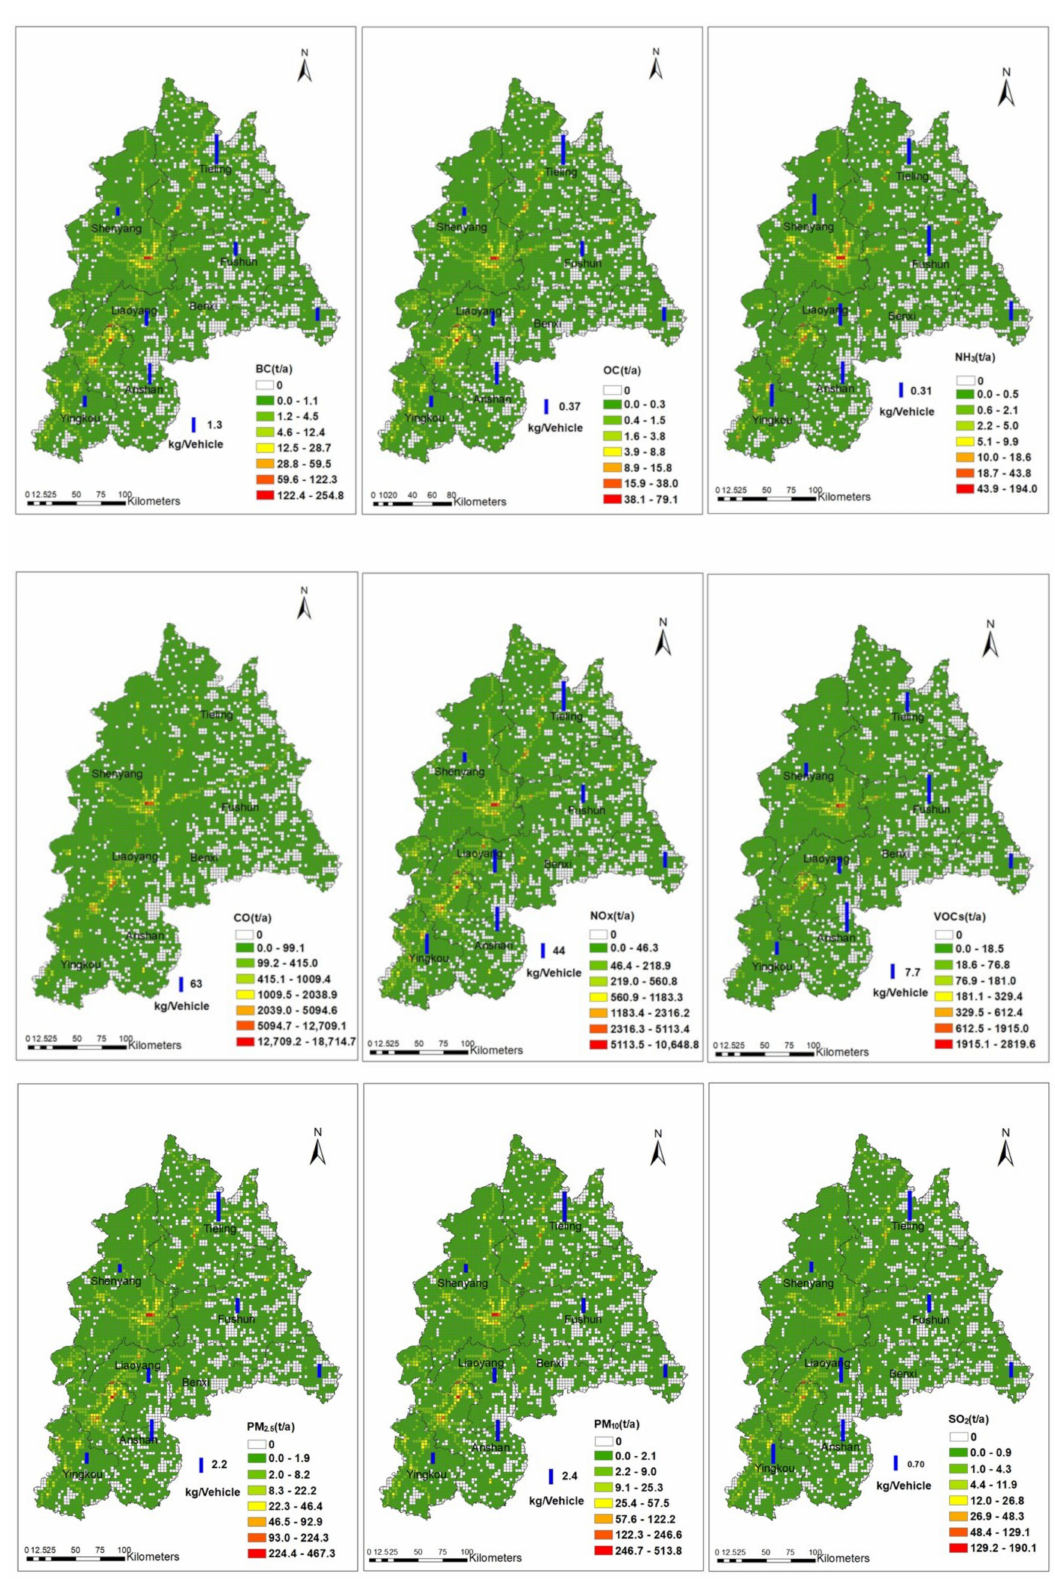
Figure 7. Spatial distribution of pollutant emissions and emissions per vehicle (kg/vehicle) in the CLUA